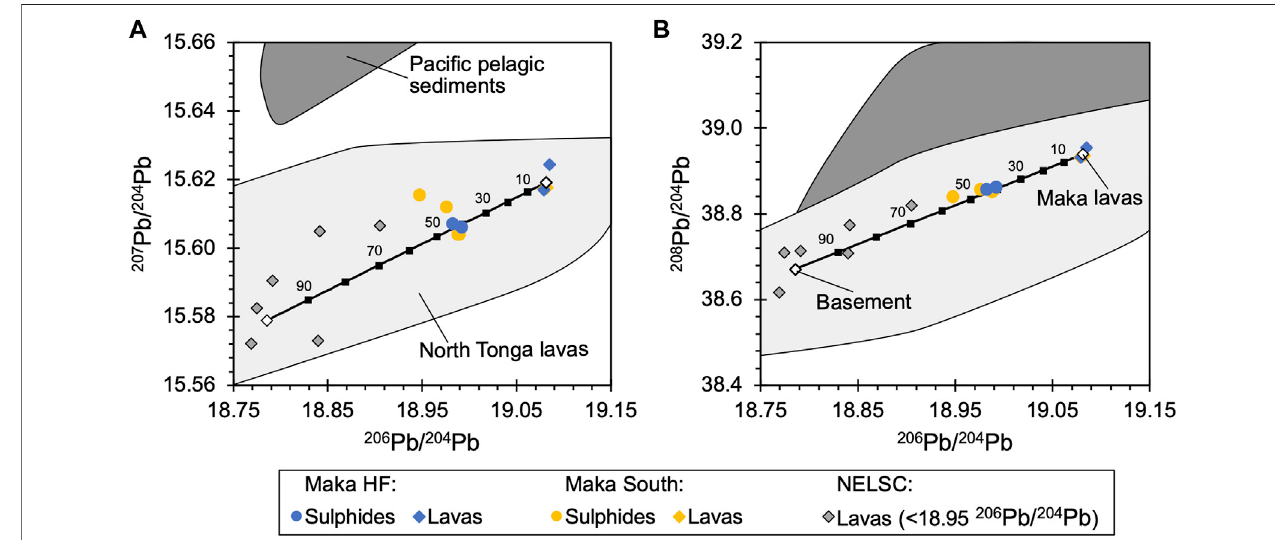
FIGURE 7 | Comparison of (A) 207 Pb/ 204 Pb and (B) 208 Pb/ 204 Pb versus 206 Pb/ 204 Pb between the Maka sea fl oor lavas and vent sulphides. Note that the sea fl oor lavas are more radiogenic than the associated hydrothermal sulphides pointing towards a second less radiogenic reservoir in the reaction and/or up fl ow zone beneath the Maka vent fi eld, which is suggested to be comparable to the sea fl oor lavas nearby the Maka vent system and from adjacent segments in the NELSC (e.g., < 18.95 in 206 Pb/ 204 Pb;NELSCdata).Themixing-line(blackline)quanti fi esthecontributionfromthesetworeservoirs,aspreservedintheventsulphides(see Section5.4 for details). The dark grey fi eld re fl ects the compositional range of Paci fi c pelagic sediments (Regelous et al., 1997; Ewart et al., 1998; Beier et al., 2017) and the light grey fi eld represent the Pb isotope variation of other North Tonga lavas (Regelous et al., 1997; Wendt et al., 1997; Ewart et al., 1998; Falloon et al., 2007; Falkenberg et al., 2021).